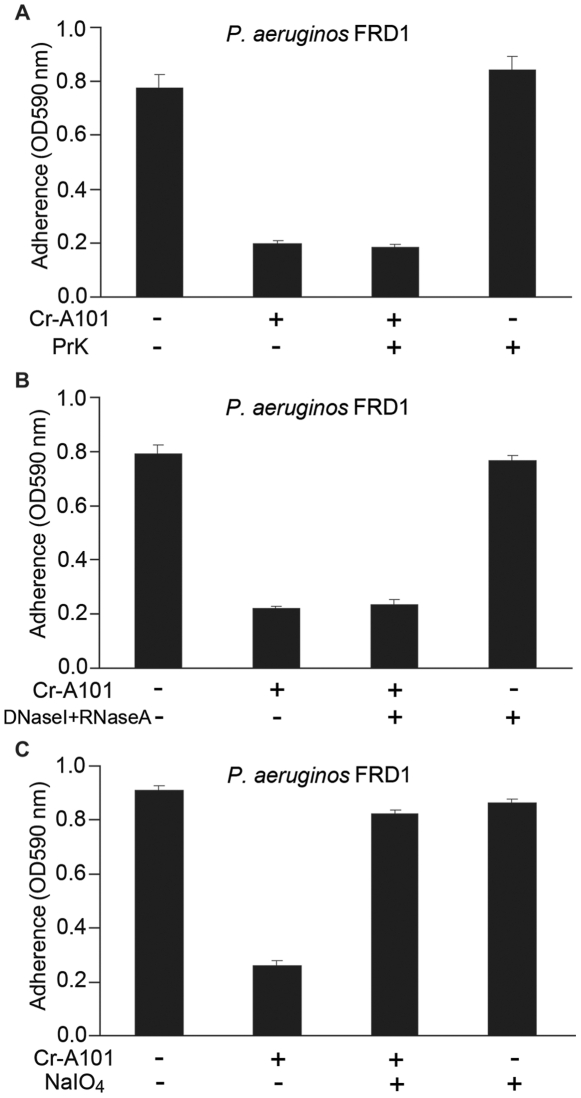
Effect of Proteinase K, Nuclease and NaIO4 on the activity of A101.Crude-A101 (150 mg/ml) was respectively treated with proteinase K (1 mg/ml) (A), DNaseI (100 µg/ml) + RNaseA (25 µg/ml) (B) or NaIO4 (20 mM) (C) at 37°C for 12 h, then taken to measure the antibiofilm activity. The strain used in this experiment was P. aeruginosa FRD1. Error bars represent SD of three independent experiments. “Cr-A101”: Crude-A101.